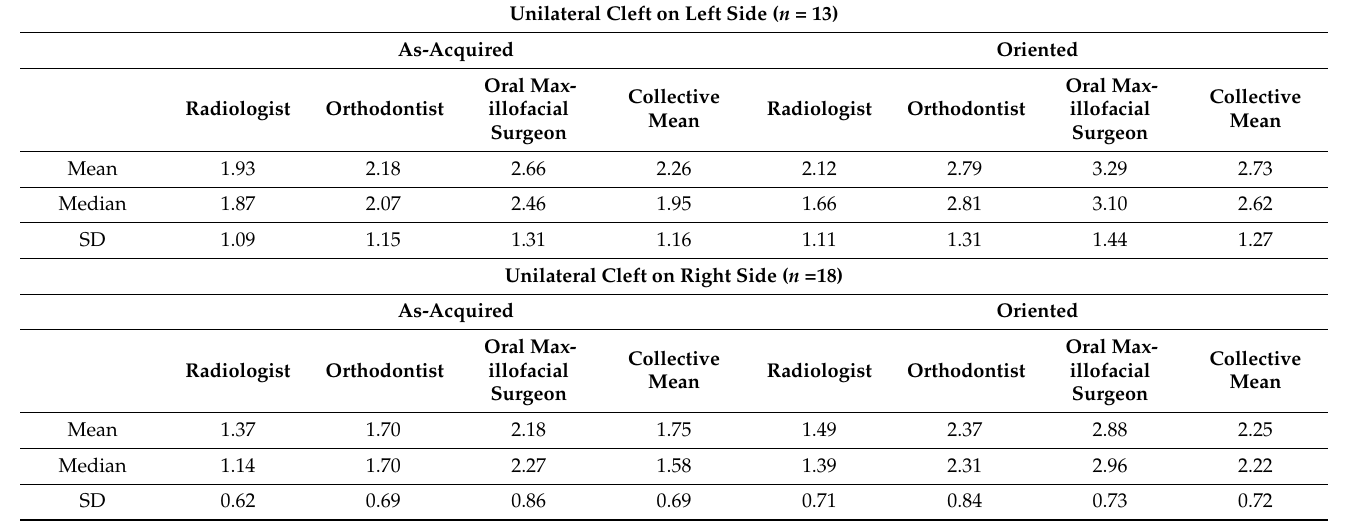
Figure 4. Cleft volumes by different observers: ( A ) values from as ‐ acquired volume, ( B ) values from oriented volumes. Table 3. Mean bone volume for unilateral cleft on left and right